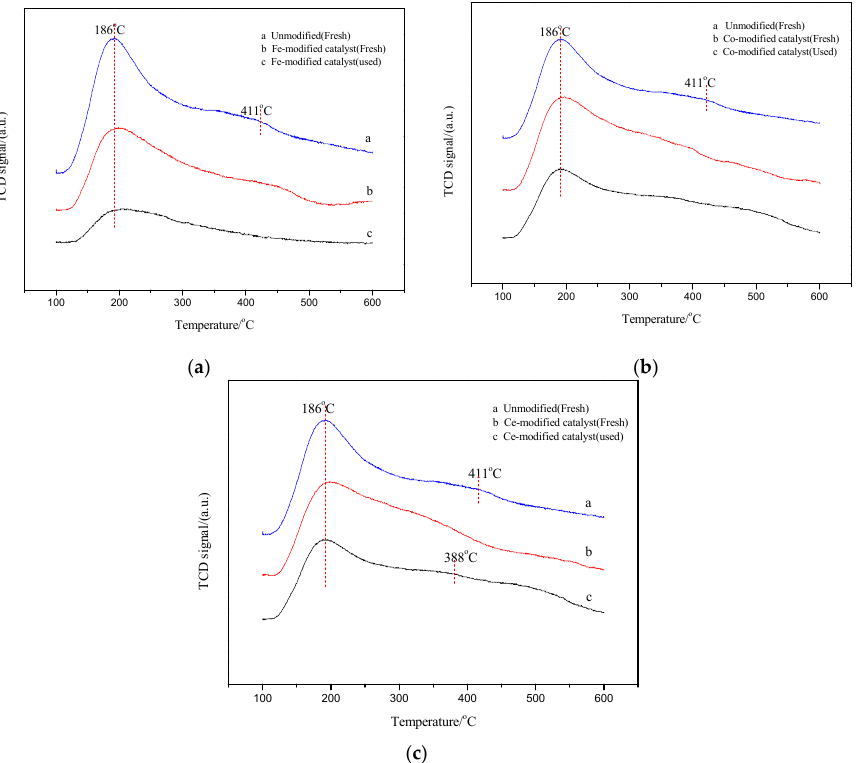
Figure 4. NH 3 -TPD diagram of SO 2 poisoning catalyst before addition of different transition metal additives (( a ) Fe, ( b ) Co, ( c ) Ce).